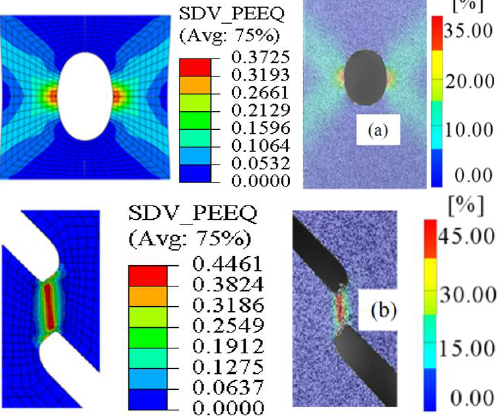
Figure 12. Comparisons between the simulated equivalent strain and the DIC equivalent strain: ( a ) specimen with a central hole; ( b ) in-plane shear specimen.